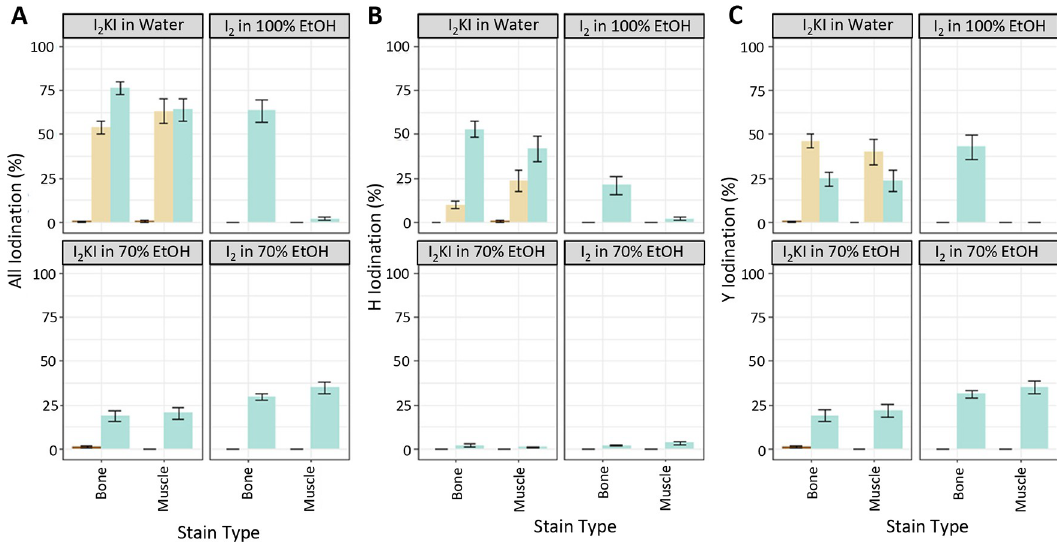
Fig 7. Percentage iodination of muscle and bone. Total iodination (A), H iodination (B), and Y iodination (C) percentages calculated from 1000 bootstraps of peptide level iodination for both bone and muscle. Pre- and post-staining indicated by dark brown and teal bars, respectively. Interim staining of the I 2 KI in water specimen is indicated with tan